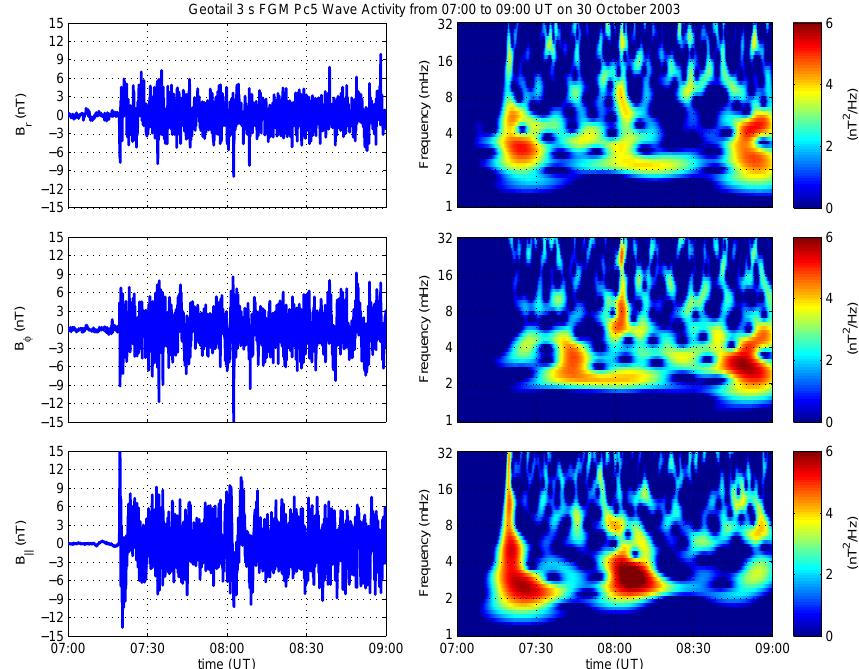
Fig. 10. Event 1: 07:00–09:00UT, 30 October 2003. As in Fig. 8 but for the Geotail Pc5